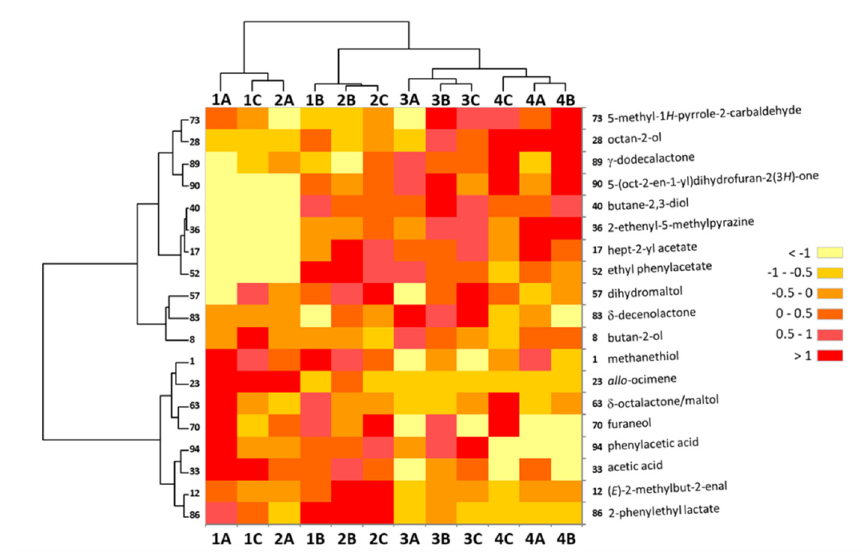
Figure 4. Heatmap displaying the results of a hierarchical cluster analysis (HCA) conducted independently on both samples and variables (OAs) dimensions, for the 38 “discriminant” OAs determined by both NIF di ff erence threshold and khi 2 test (see text). NIF values importance varies from > 1 (highest value, in red) to < − 1 (lowest values, in yellow). OA numbers are those found in Table 1. The data were centered and scaled; dissimilarity Euclidian distances were used with the Ward amalgamation method; %(std) non-specific filtering was used with a 50% threshold, resulting in the display of the only 19 variables with the highest std. An HCA conducted on the samples with the 38 variables, showing the same four distinctive clusters displayed here, may be found in Appendix B (Figure A4) for clarity